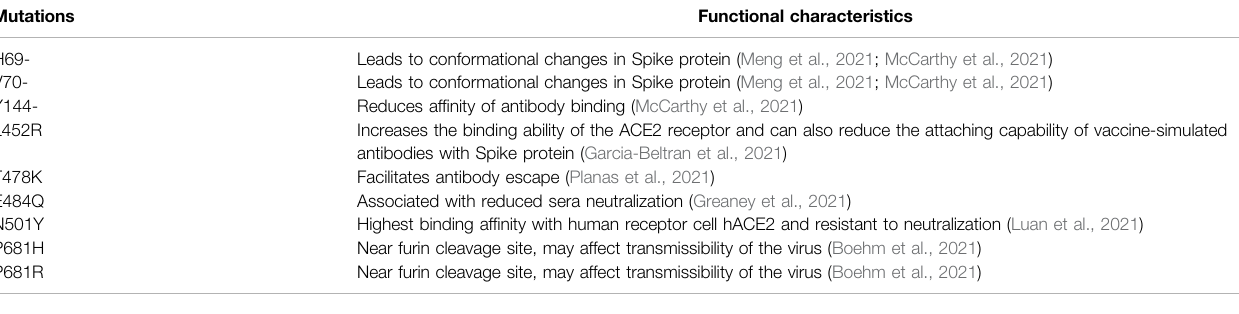
TABLE 4 | Functional characteristics of some important mutations. Mutations